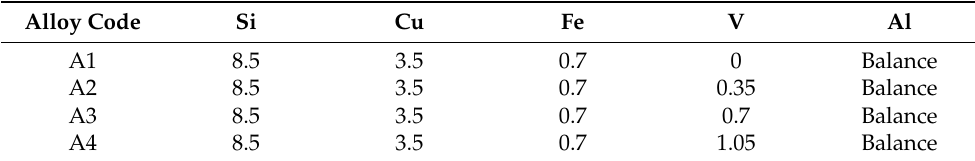
Table 1. Nominal chemical compositions of alloys (wt.%). Alloy